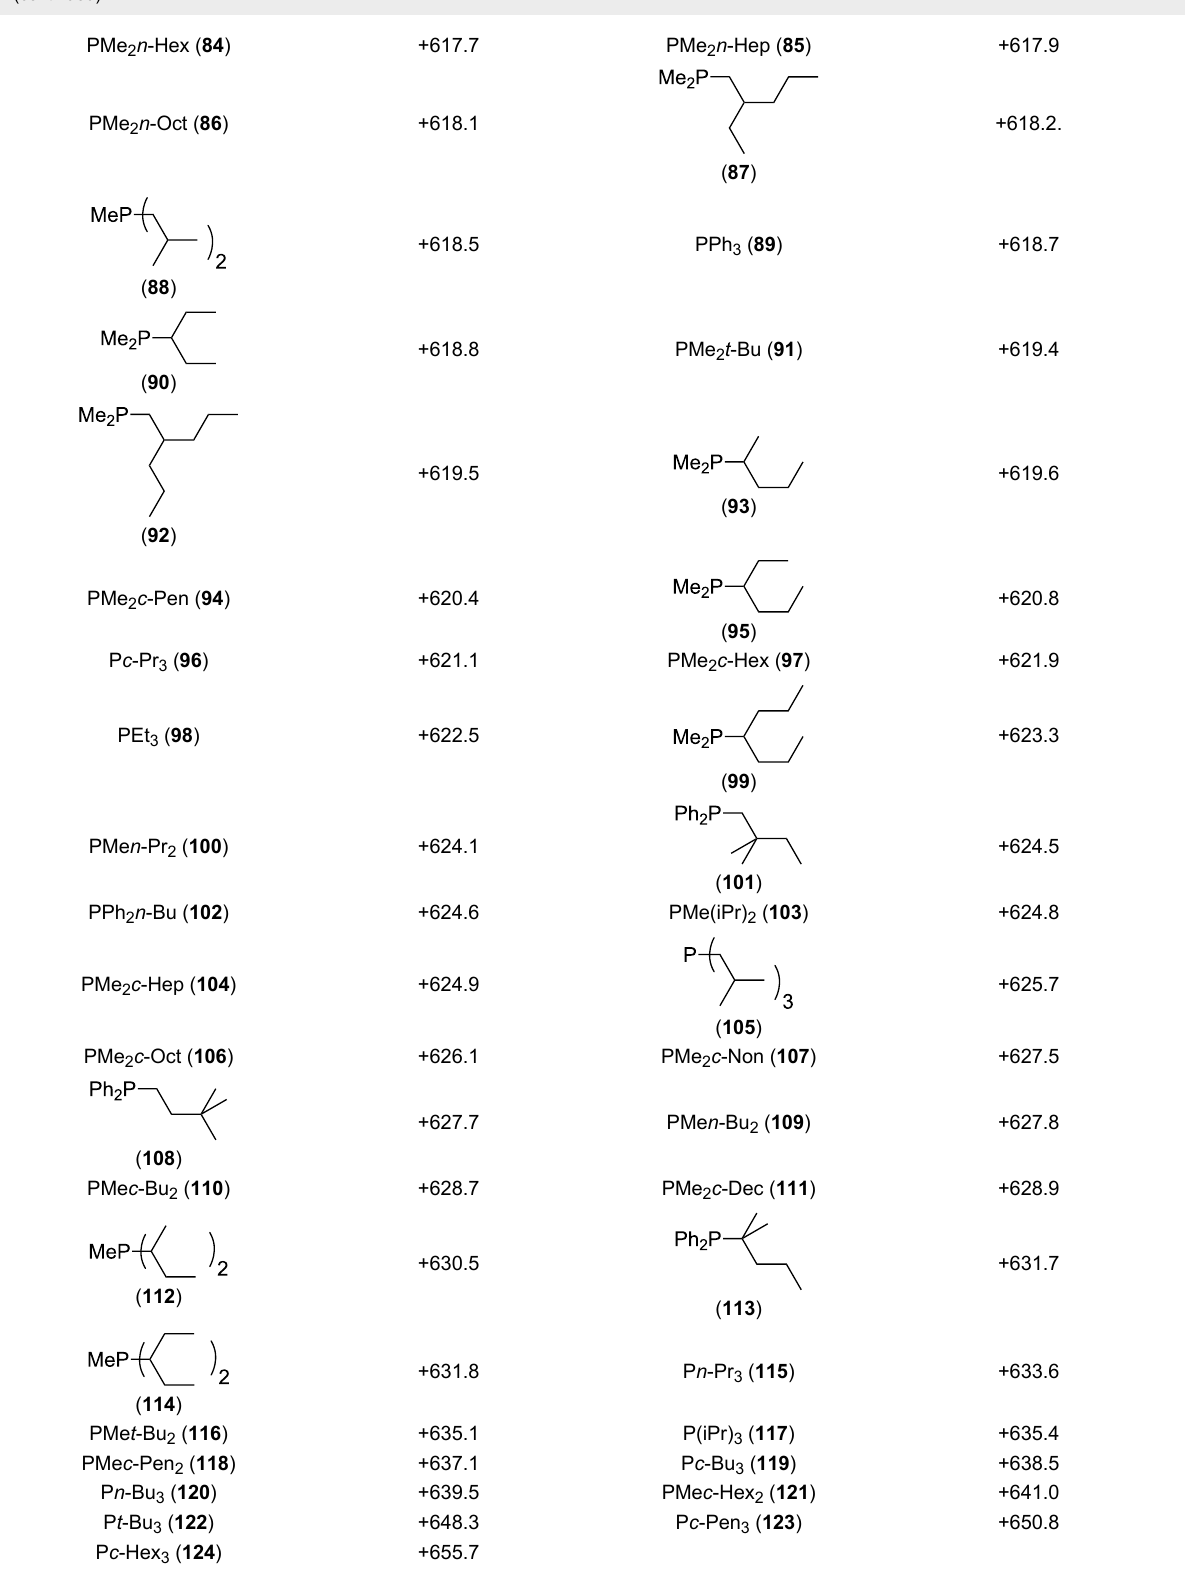
Table 2: MCA values of saturated trialkylphosphanes without heteroatoms, PPh 3 , PH 3 , PH 2 Me and PHMe 2 , ordered by increasing MCA values.